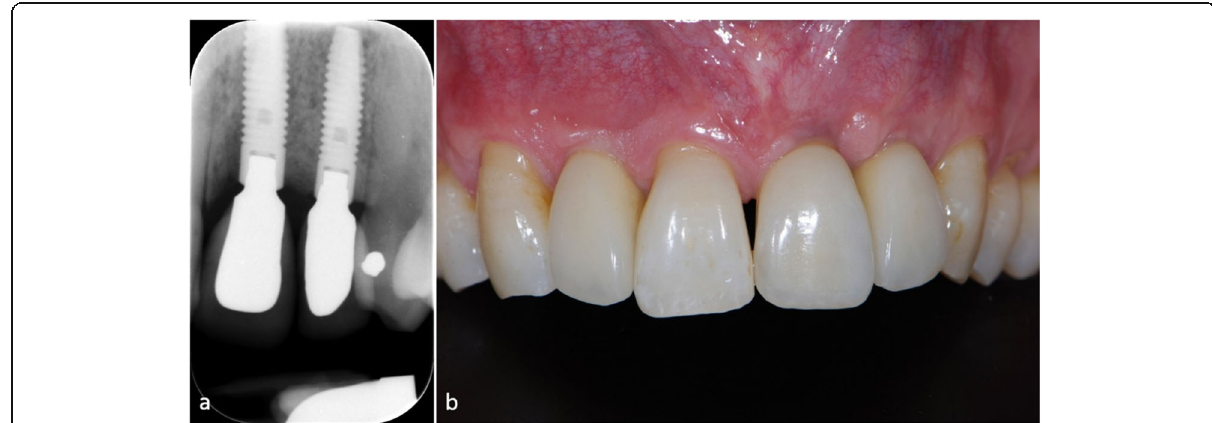
Fig. 4 Reference: The apical dental x-ray 10 months after implantation ( a ) and the consecutive prosthetic reconstruction ( b ), Courtesy of N. Nänni & D. Thoma, Clinic of Reconstructive Dentistry, University of Zurich